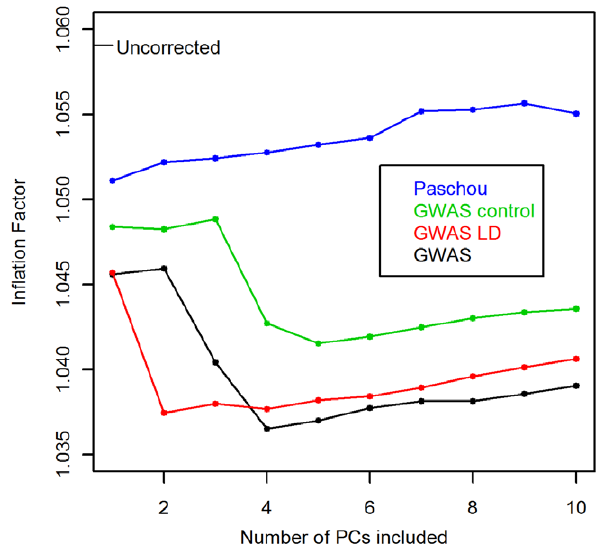
Figure 3. Comparison of effect on the inflation factor l of controlling for ancestry. The first 10 PCs obtained through Paschou PCA, GWAS control PCA, GWAS PCA and GWAS LD PCA are used as covariates in testing genome-wide association to ovarian cancer. Note that the Paschou panel was designed to capture only one significant PC.